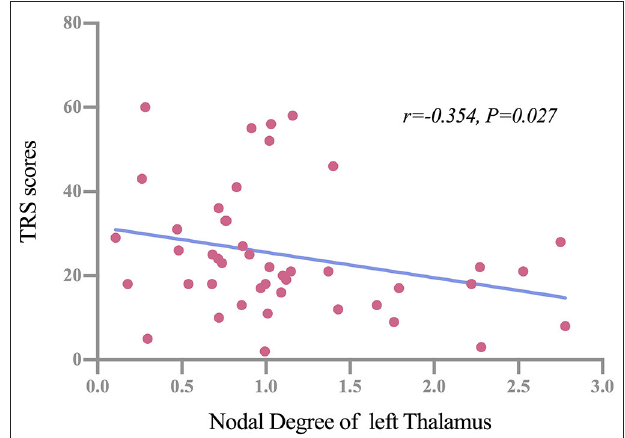
FIGURE 4 | Partial correlations between the nodal degree of the left thalamus and TRS scores among patients in the SleET group. SleET, essential tremor with poor sleep quality; TRS, Fahn-Tolosa-Marin Tremor Rating